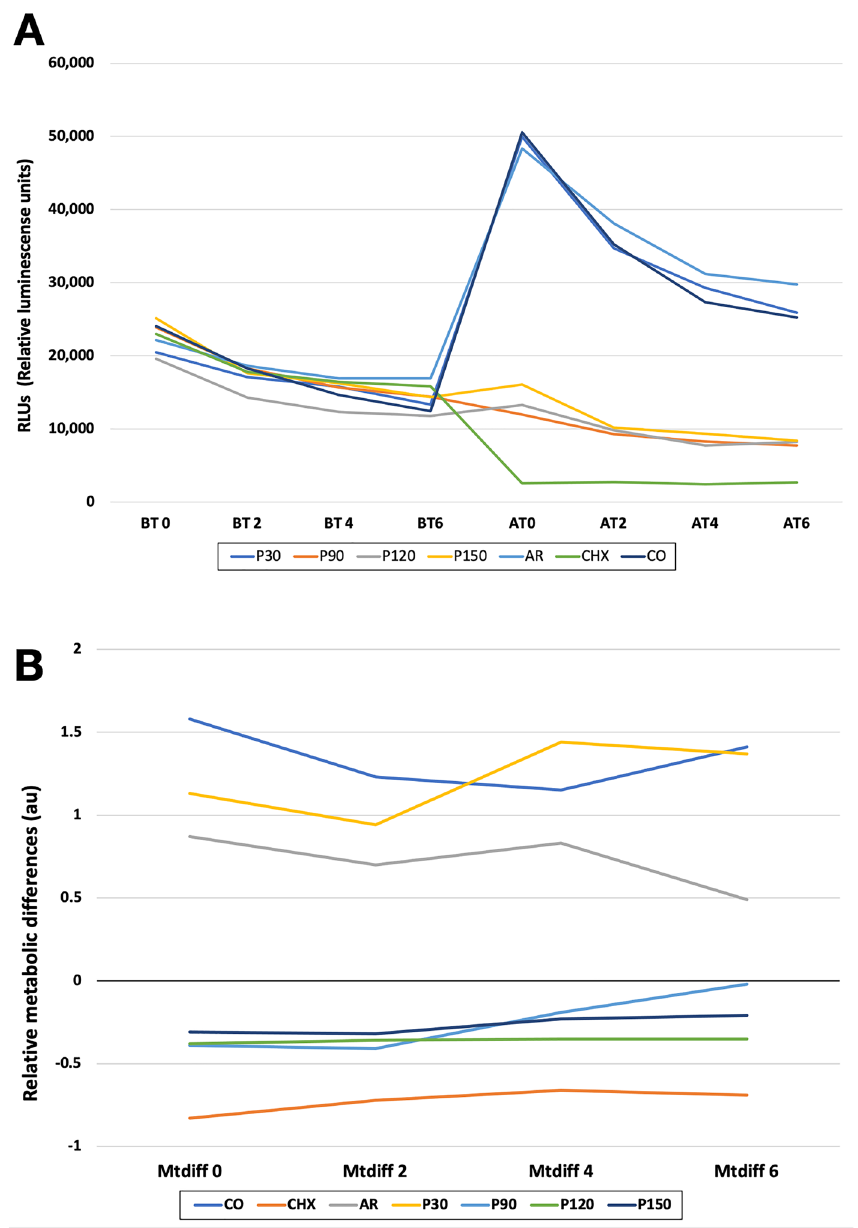
Figure 2. Antibacterial efficacy of experimental treatments against Streptococcus mutans biofilms based: ( A ) Metabolic activity in terms of Relative Luminiscense Units (RLU) of the S. mutans biofilms before (BT0–BT6) and after (AT0–AT6) experimental treatments; and ( B ) Metabolic activity of the experimental treatments against S. mutans biofilms in terms of metabolic activity differences calculated for each point time. The groups P90, P120 and P150 had antibacterial effect. However, CHX was the most antibacterial treatment. P30, AR and CO groups showed higher metabolic